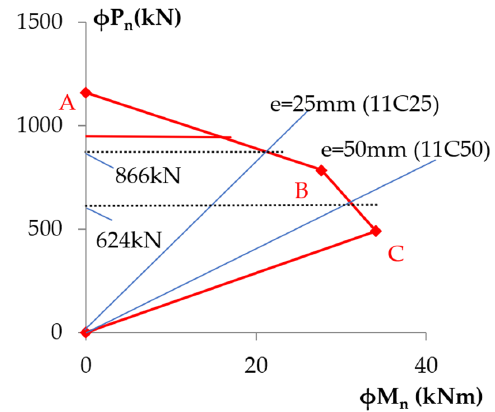
Figure 18. Simplified P-M diagram.